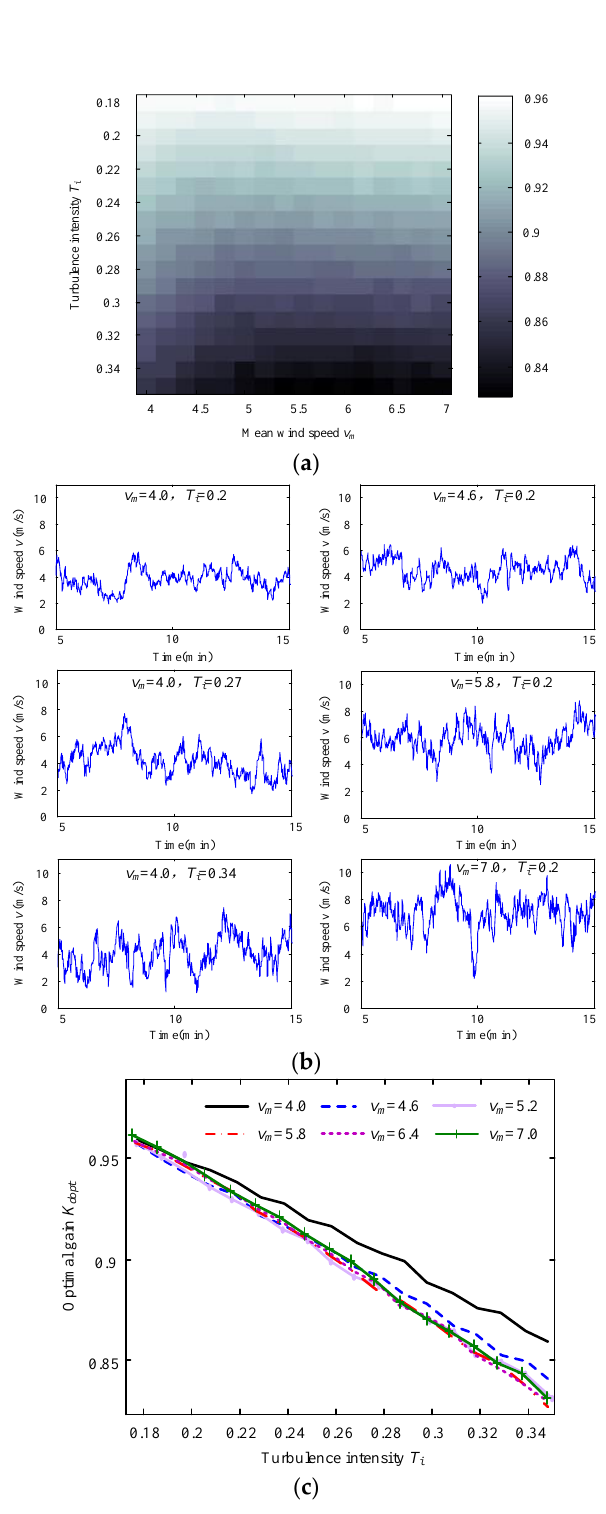
Figure 8. Results of off-line learning: ( a ) optimal gains with different mean wind speeds and turbulence intensities; ( b ) selected results of inputs (i.e., wind speed with different mean values and turbulence intensities); and ( c ) selected results of outputs (i.e., optimal gains with fixed mean wind speeds and variable turbulence intensities).